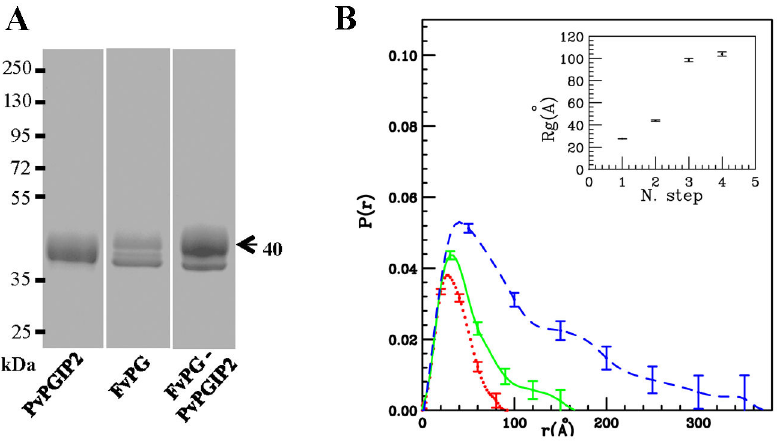
Figure 4. Analysis of the complex formed by FvPG and PvPGIP2. A, SDS-PAGE analysis of the FvPG-PvPGIP2 cross-linked complex. The single proteins are also reported. B, Calculated pair distribution functions of the first three SAXS patterns collected for the FvPG-PvPGIP2 complex; red dot-line, green continuous-line and blue dash-line correspond to three consecutive data sets (interval times about 20 h), respectively. In the inset, the Rg values of four consecutive data sets are shown. doi: